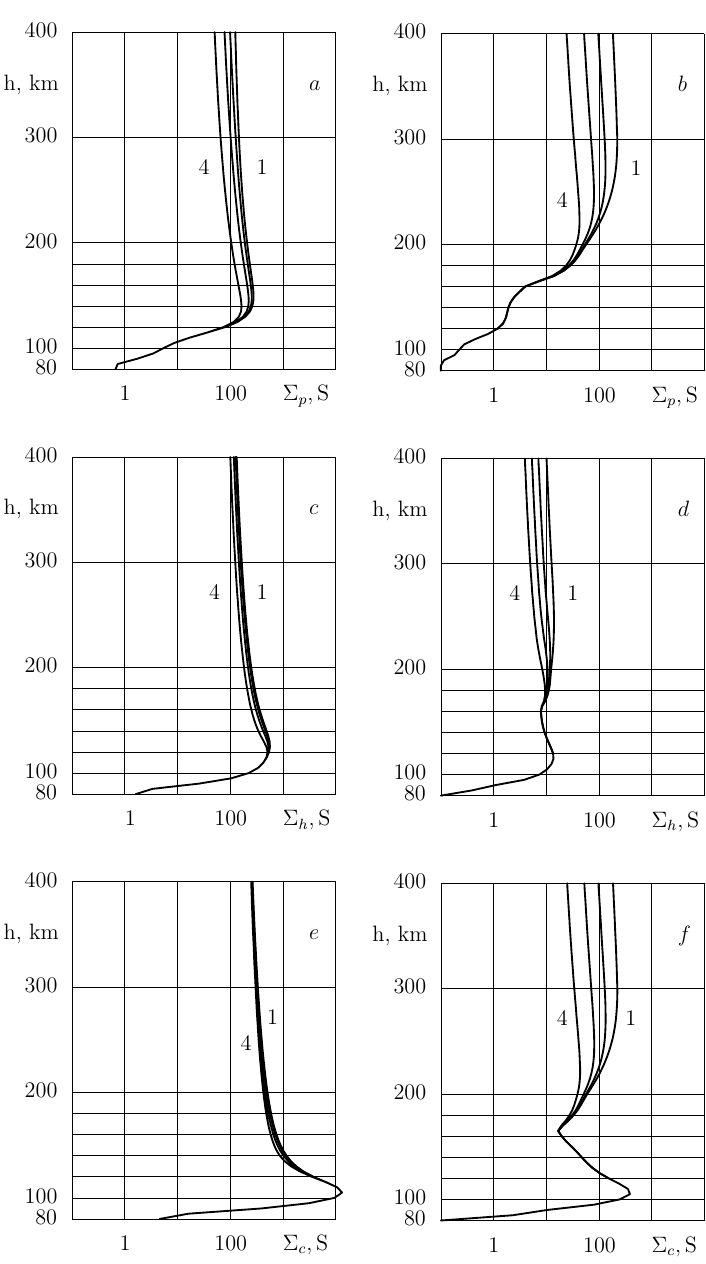
Fig. 5. Conductances 6 P , 6 H , 6 C above the geomagnetic equator (curves 1). The left and right columns present midday and midnight values, respectively. Curves 2, 3, 4 are for effective conductances for t 0 = 1 / 3 , 1 ,